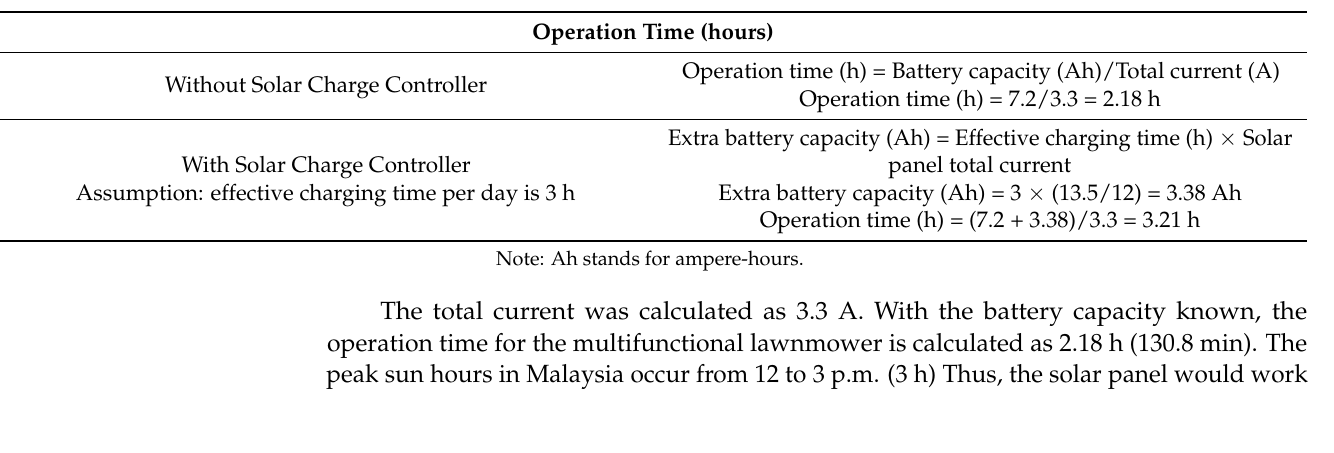
Table 29. Calculation of lawnmower operation